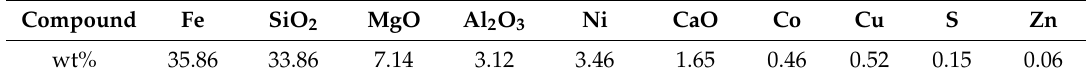
Table 1. The elemental composition of the industrial nickel